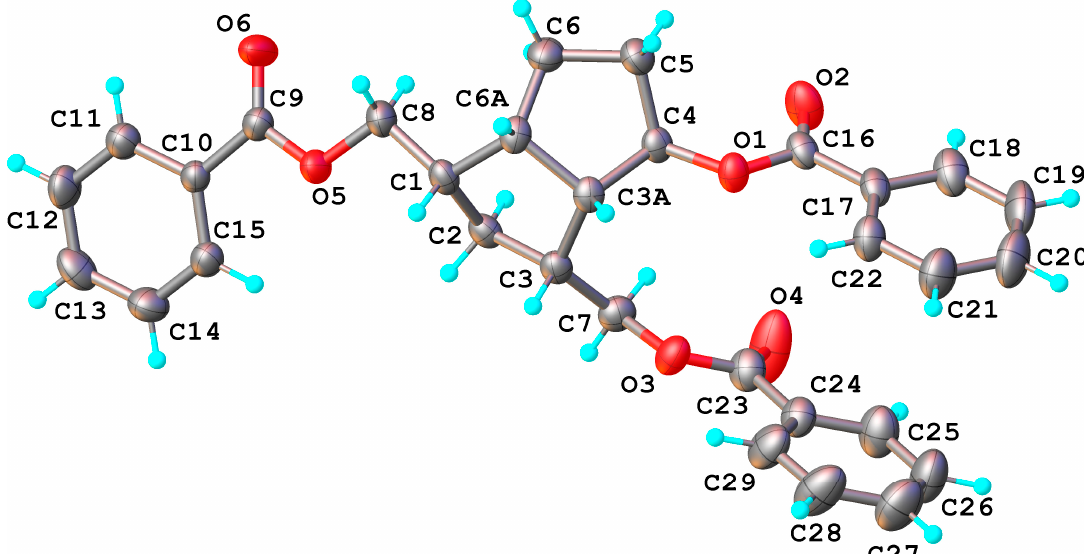
Figure 4. X-ray molecular structure of non-symmetrical triol tribenzoate compound 3 with atom labeling scheme and thermal ellipsoids at 50% probability level.